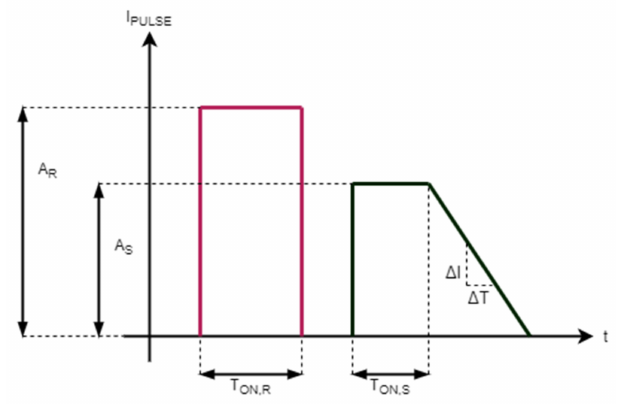
Figure 3. SET and RESET pulses and configurable